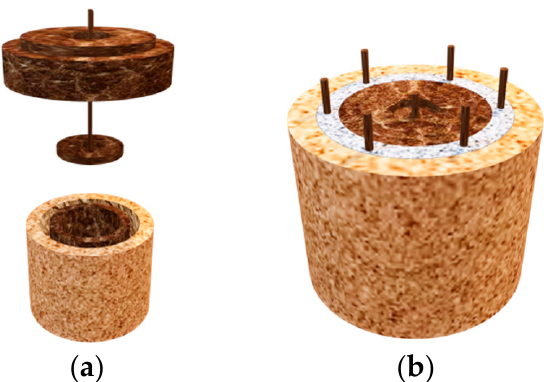
Figure 1. The 3D structure of a cement sheath seal integrity evaluation device: ( a ) cement slurry curing and maintenance; ( b ) posteriori channeling after disassembly.